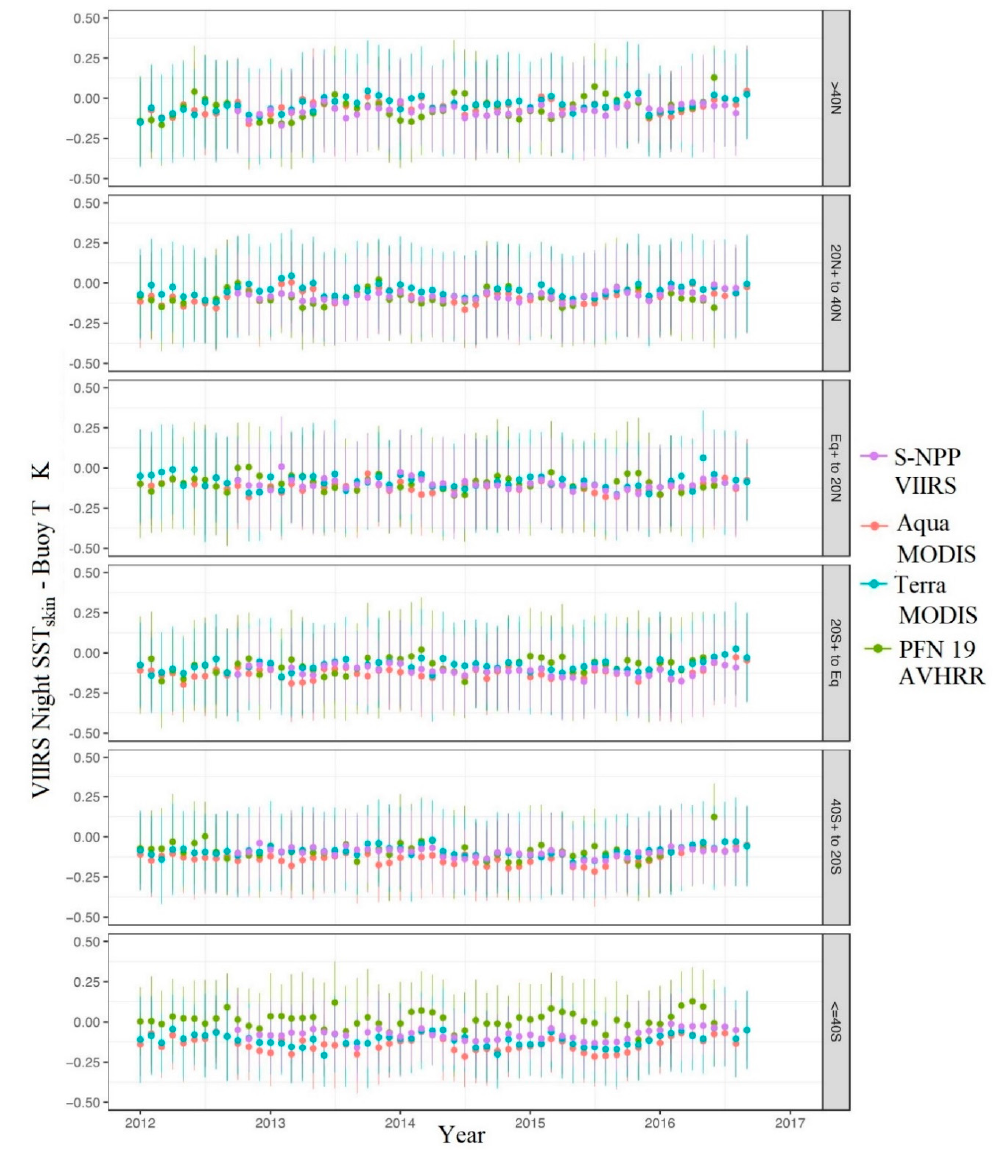
Figure 15. Multi-sensor global monthly median and robust standard deviations of the differences between S-NPP VIIRS R2016.0 SST skin and subsurface temperatures measured from buoys in the latitude bands (shown at right) used in the atmospheric correction algorithm. The differences between NASA MODIS R2014.0.1 Terra and Aqua , and NOAA AVHRR Pathfinder V5.3 on NOAA-19 SST skin are also shown. Dots represent the monthly median differences and the whiskers represent the robust standard deviations.